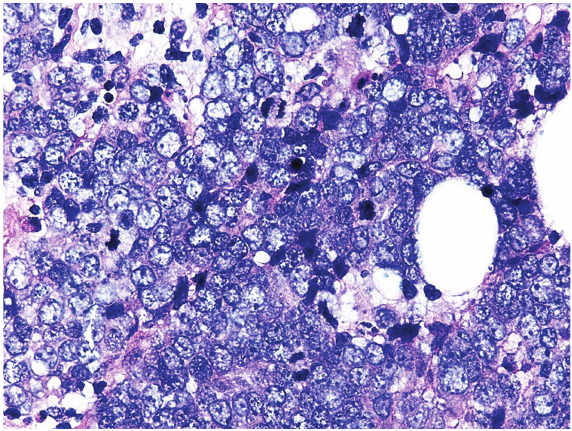
Figure 3: The neoplastic cells show vague cell borders, large pleo- morphic nuclei, and numerous mitotic figures.